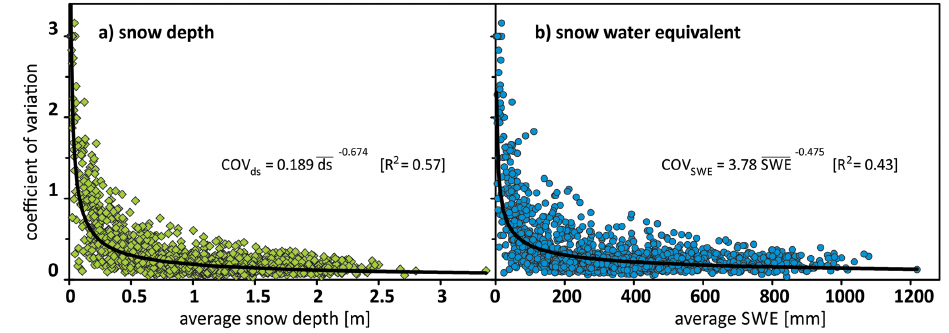
Figure 1. Correlation of the coefficient of variation with the snowcourse average for (a) snow depth, and (b) snow water equivalent.